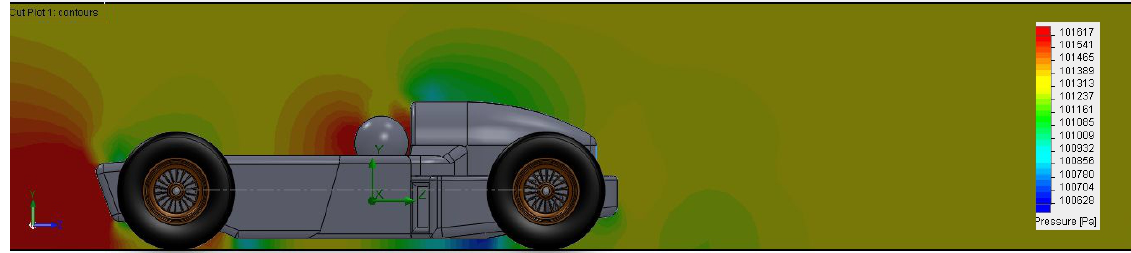
Figure 6. Air flow pressure distribution on prototype (lateral view).